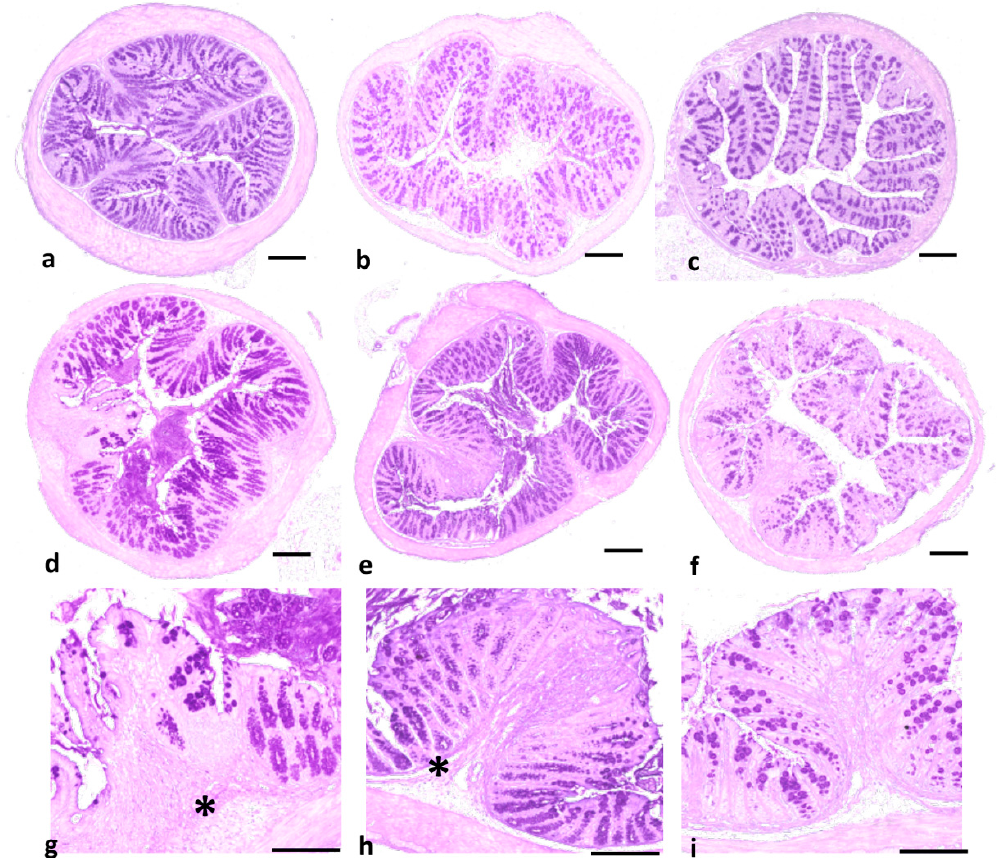
Figure 5. Analysis of histological colon sections from DSS-induced colitis: ( a – c ) colon sections from mice receiving water (control), C. albicans alone and DHMB, respectively; ( d ) colon sections from mice receiving DSS; ( e ) colon sections from mice receiving C. albicans and DSS; and ( f ) colon sections from CaD mice treated with DHMB; ( g – i ) colon sections from either DSS mice or CaD show tissue destruction, an important inflammatory cell infiltrate and oedema in the mucosa and submucosa of colon wall structures (*). Scale bars represent 50 µm ( a – f ) and 10 µm ( g–i ). The number of C. albicans colony-forming units (CFUs) and microbiota changes were assessed in freshly collected stool samples from each tagged mouse. A high number of C. albicans CFUs was